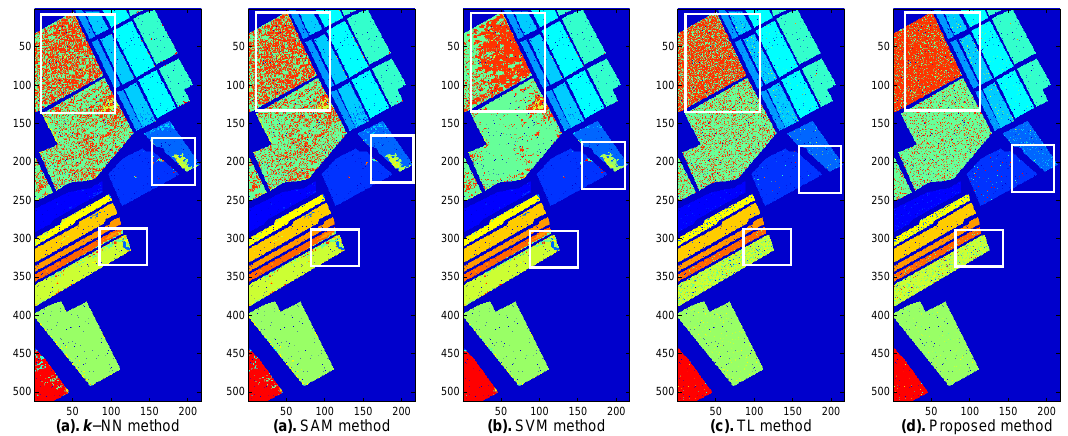
Figure 14. Classification maps of ( a ) SAM method; ( b ) SVM method; ( c ) TL method, and ( d ) proposed method, AVIRIS Salinas dataset, 16 classes, 1% training